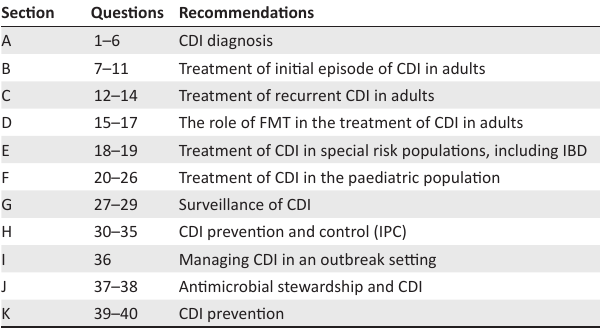
TABLE 1: Quick reference for